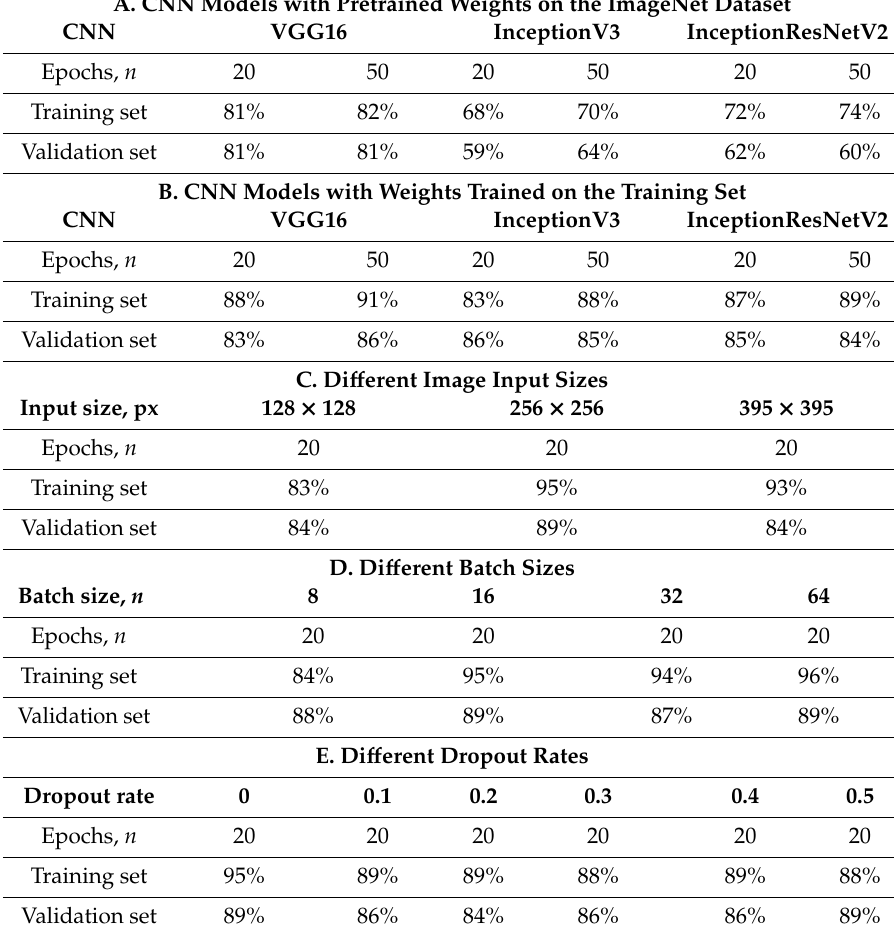
Table 2. Classification accuracy of di ff erent convolutional neuronal network (CNN) models during the optimization